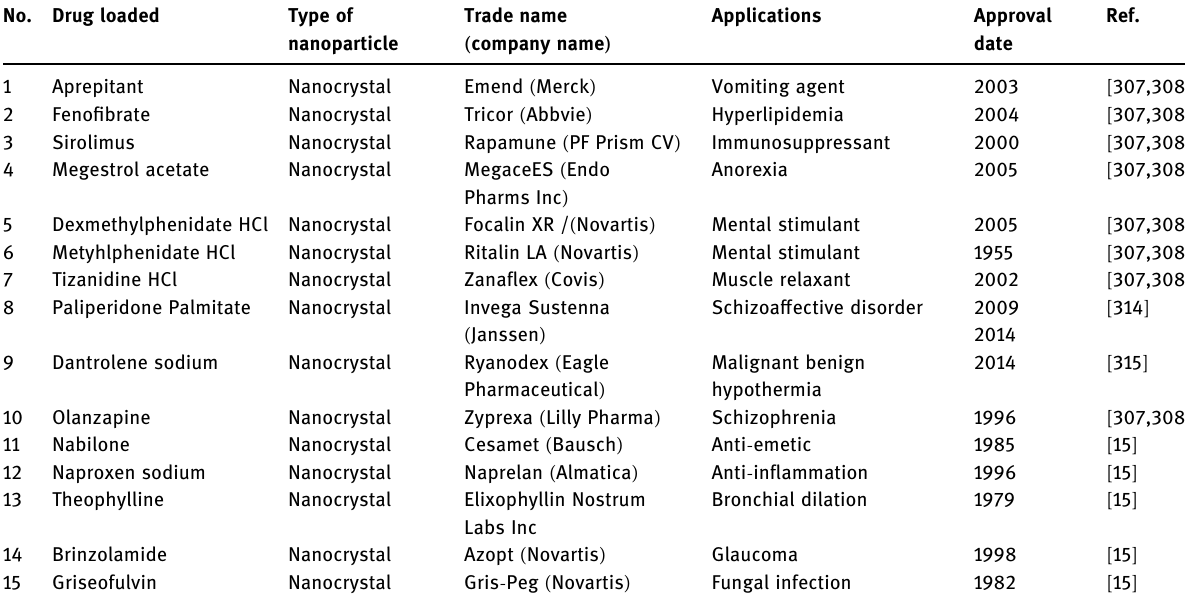
Table 3: Approved marketed drug - loaded crystalline nanoparticles No. Drug